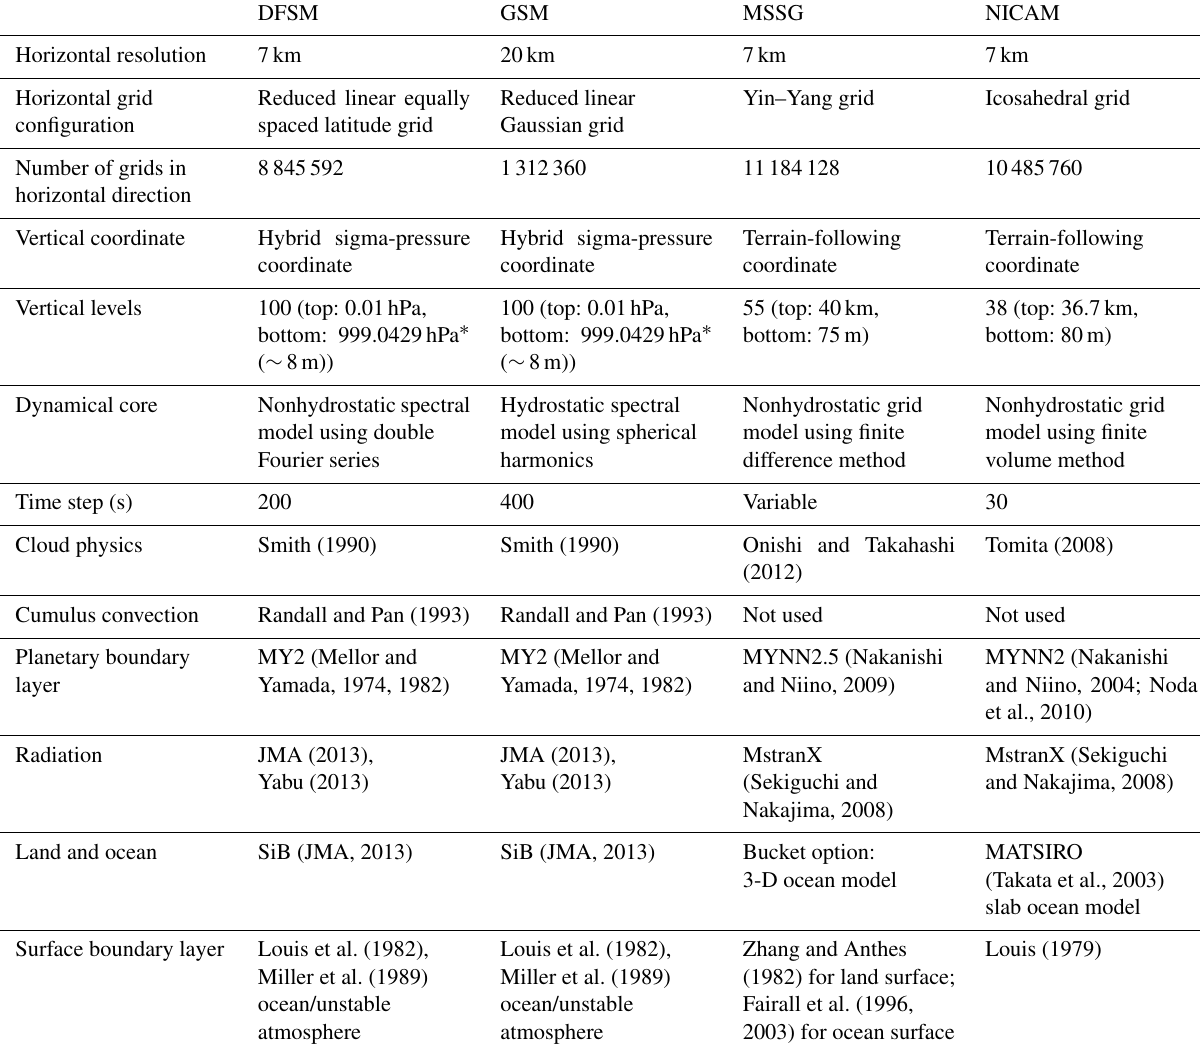
Table 4. Brief description of the specifications for each global nonhydrostatic